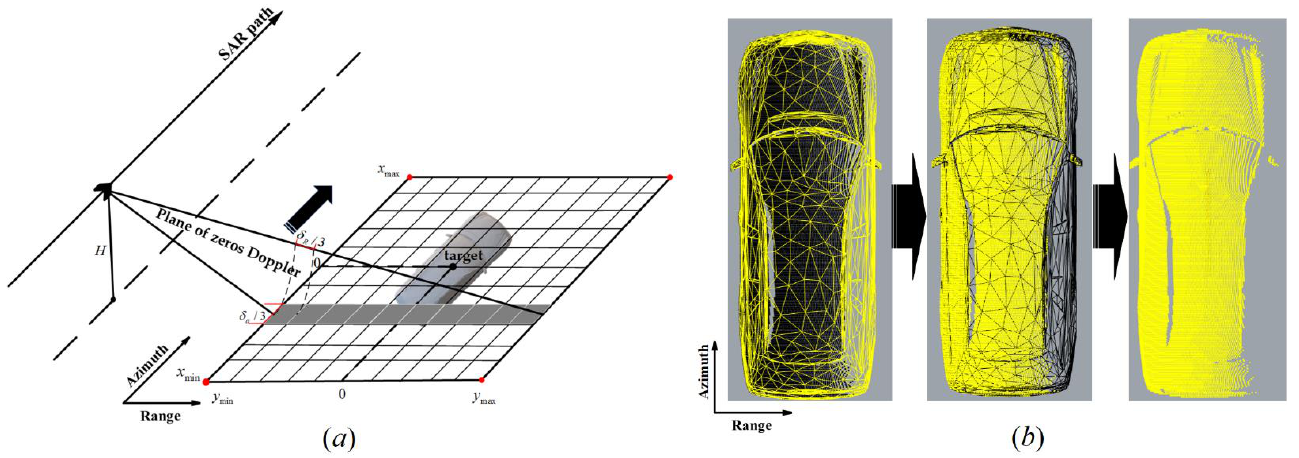
Figure 4. Calculating and recording lattice coordinates: ( a ) scanning process of radar beams; ( b ) dual-scale subdivision of facets.